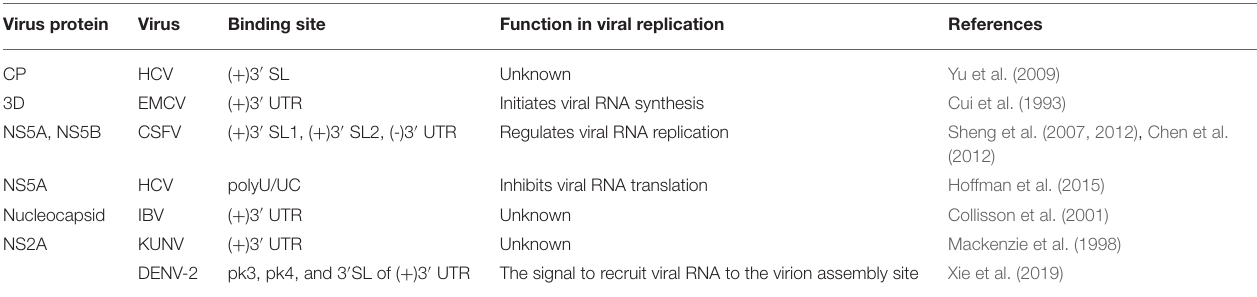
TABLE 2 | Viral proteins that interact with the 3 ′ UTRs of ssRNA( + ) viruses. Virus